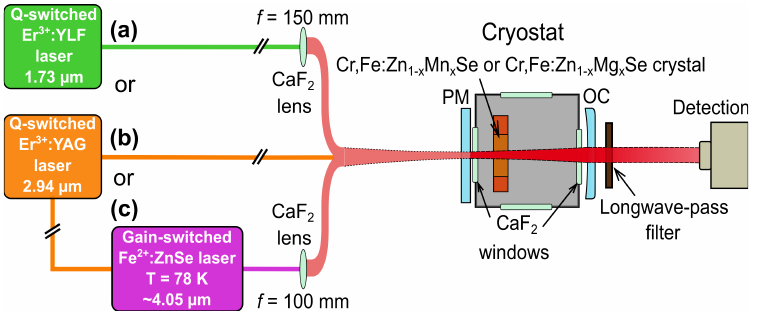
Figure 8. Cr,Fe:Zn 1 − x Mn x Se (x ≈ 0.3) and Cr,Fe:Zn 1 − x Mg x Se (x ≈ 0.3) laser systems’ experimental setup for three various pumping laser systems used: (a) Q-switched Er:YLF laser at the wavelength of 1.73 µ m is directed to pumping, (b) Q-switched Er:YAG laser at 2.94 µ m, and (c) gain-switched Fe:ZnSe laser at ∼ 4.05 µ m operated for the temperature of 78K pumped by Er:YAG laser is pumping Cr,Fe:Zn 1 − x Mn x Se (x ≈ 0.3) or Cr,Fe:Zn 1 − x Mg x Se (x ≈ 0.3) laser